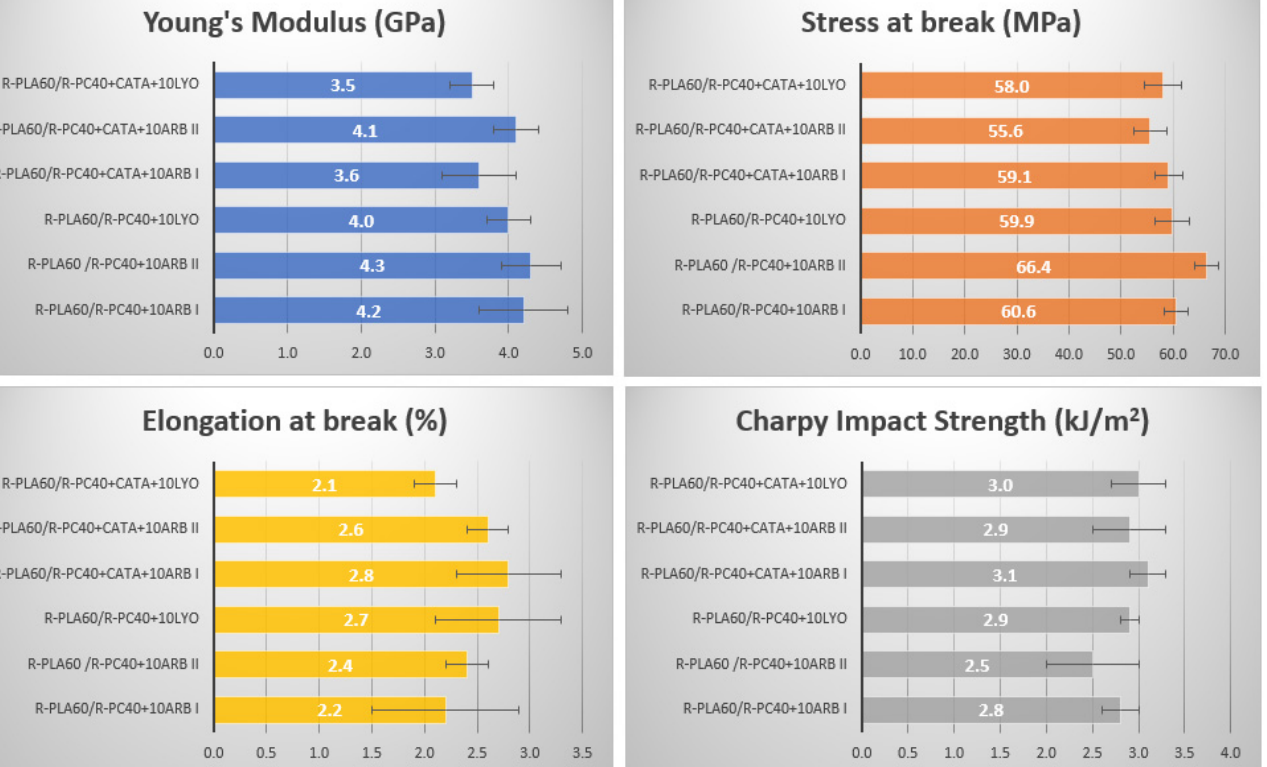
Figure 4. Mechanical properties of R-PLA/R-PC based biocomposites.